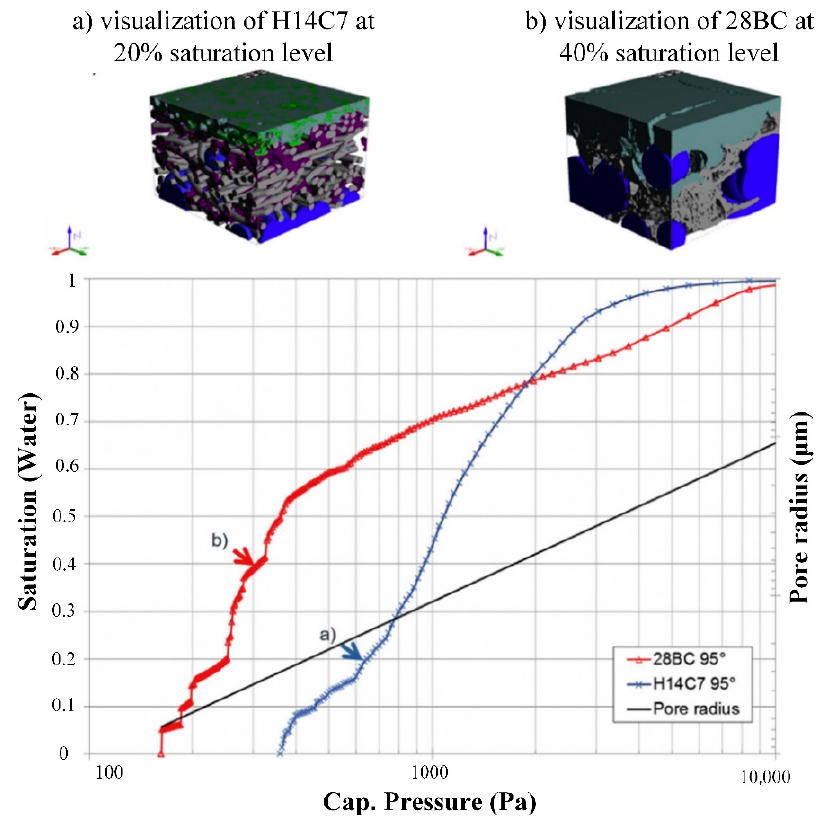
Figure 6. Water saturation and pore radius, for the two GDLs (H14C7 at 20% saturation level 181 and 28BC 40% saturation level), as a function of capillary pressure [33].